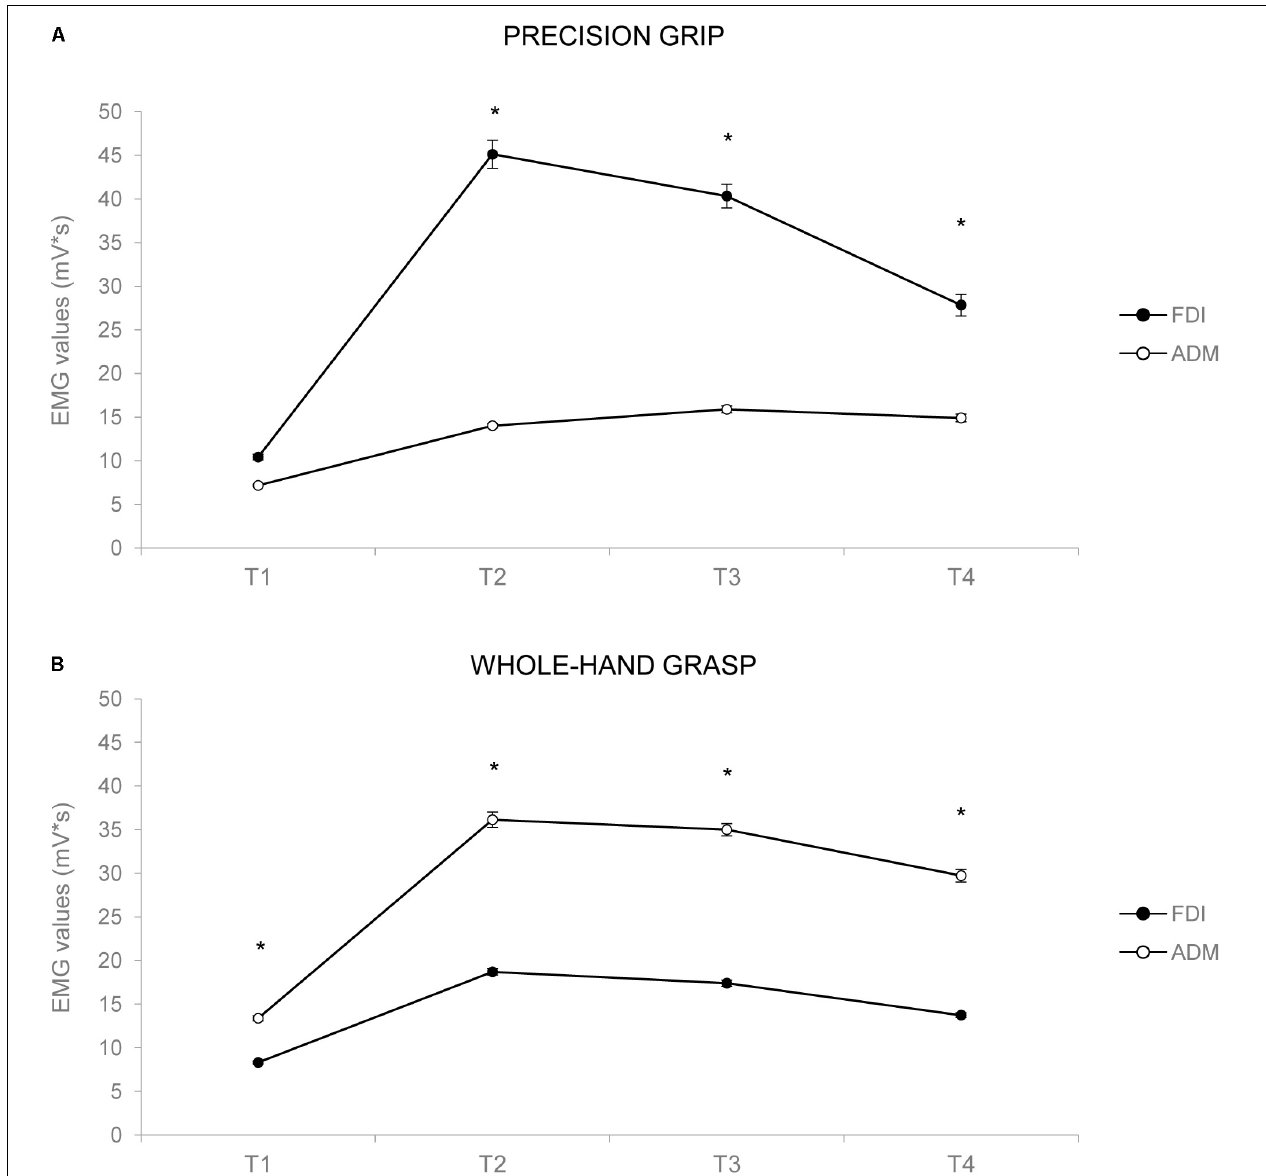
FIGURE 3 | Graphical representation of the mean values for the EMG activity across the 1-s time bins ( T 1 – T 4 ) for the FDI (black circles) and the ADM (white circles) muscles during PG (A) and WHG (B) . Bars represent SE of the mean. Asterisks indicate statistically significant comparisons ( p <